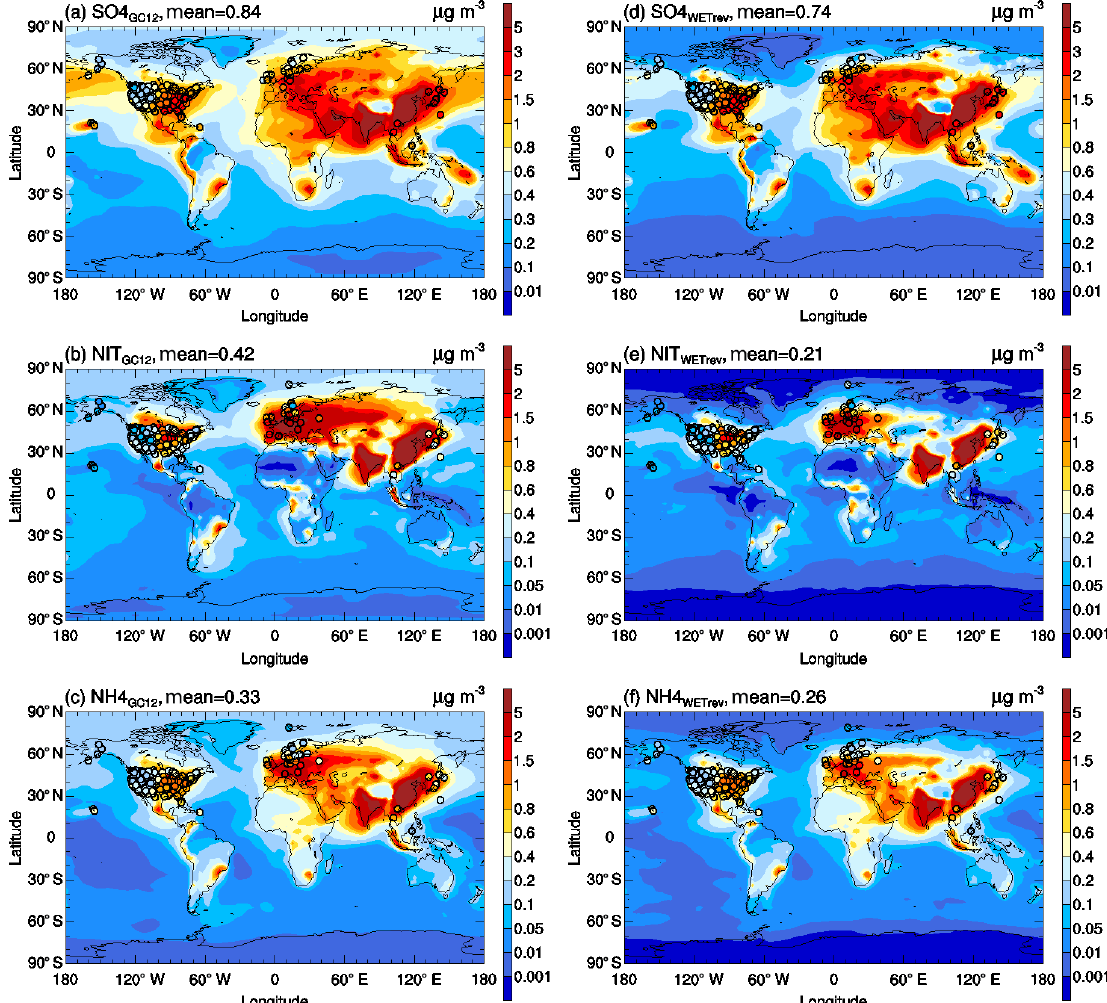
Figure 11. The same as Fig. 10 but for sulfate, nitrate, and ammonium surface mass